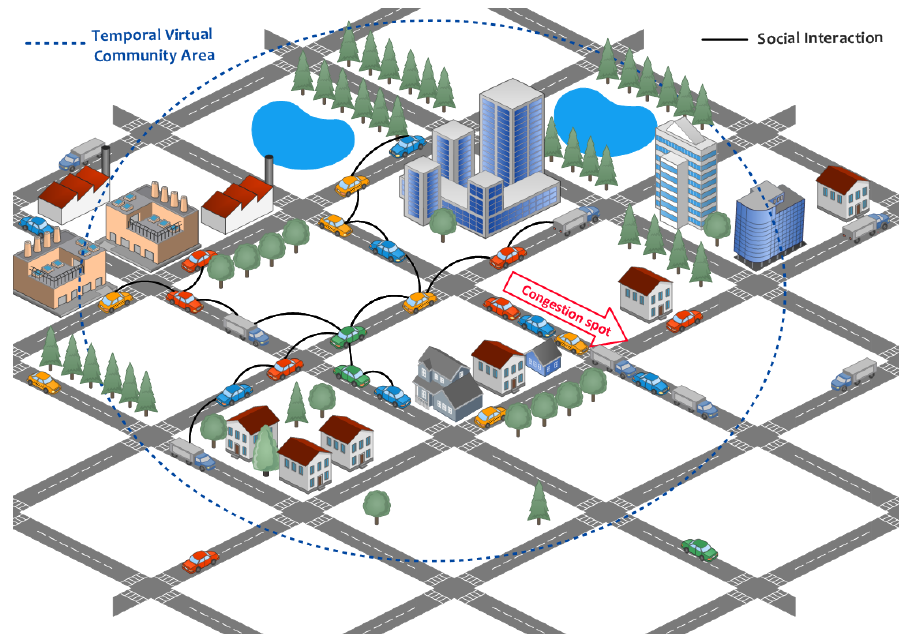
Figure 2. Temporal virtual community and social interactions area in VSNs. Algorithm 2: Collaborative route-planning for vehicles that are moving toward the congested